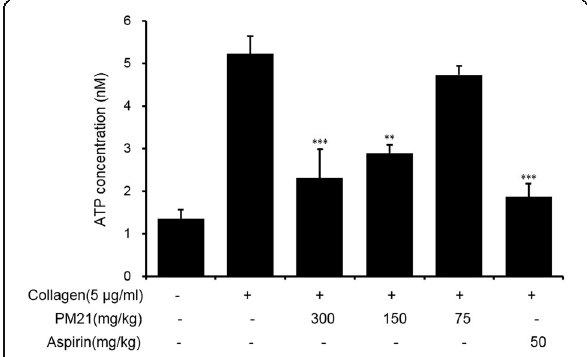
Fig. 2 Ex vivo effects of PM 21 on ATP release. Six male rats in each experimental group were treated with test samples. PM21 was orally administered daily after overnight fasting for 3 days to three test groups at the doses of 75 mg/kg, 150 mg/kg, and 300 mg/kg, and aspirin was administered to positive control group at the dose of 50 mg/kg. Blood was collected 1 h after the final treatment. Platelet aggregation was induced by adding 5 μ g/mL collagen and terminated after 5 min. ATP release was measured with a luminometer using ATP assay kit. Data show the mean±SEM of six measurements. ** p <0.01, *** p <0.001 versus vehicle